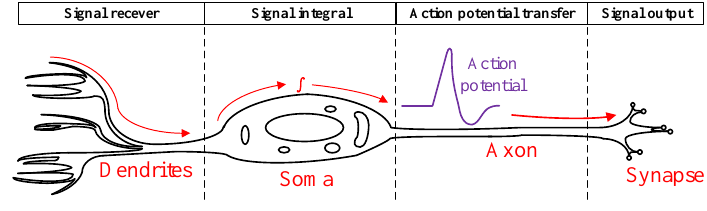
Figure 1. Sketch map of a single neuron, which consists of soma, dendrites, axon and synapse. The dendrites perform the function of signal reception, transmitting neural signals in the form of action potentials, while soma collects signals from all the